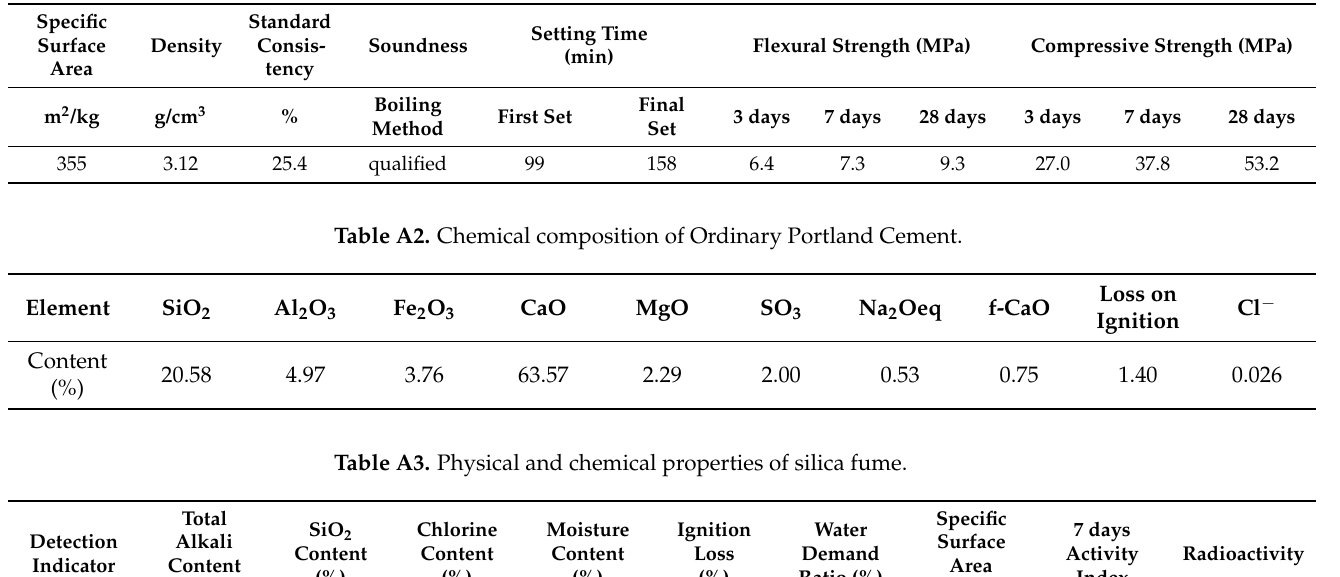
Table A1. Physical properties of Ordinary Portland Cement.